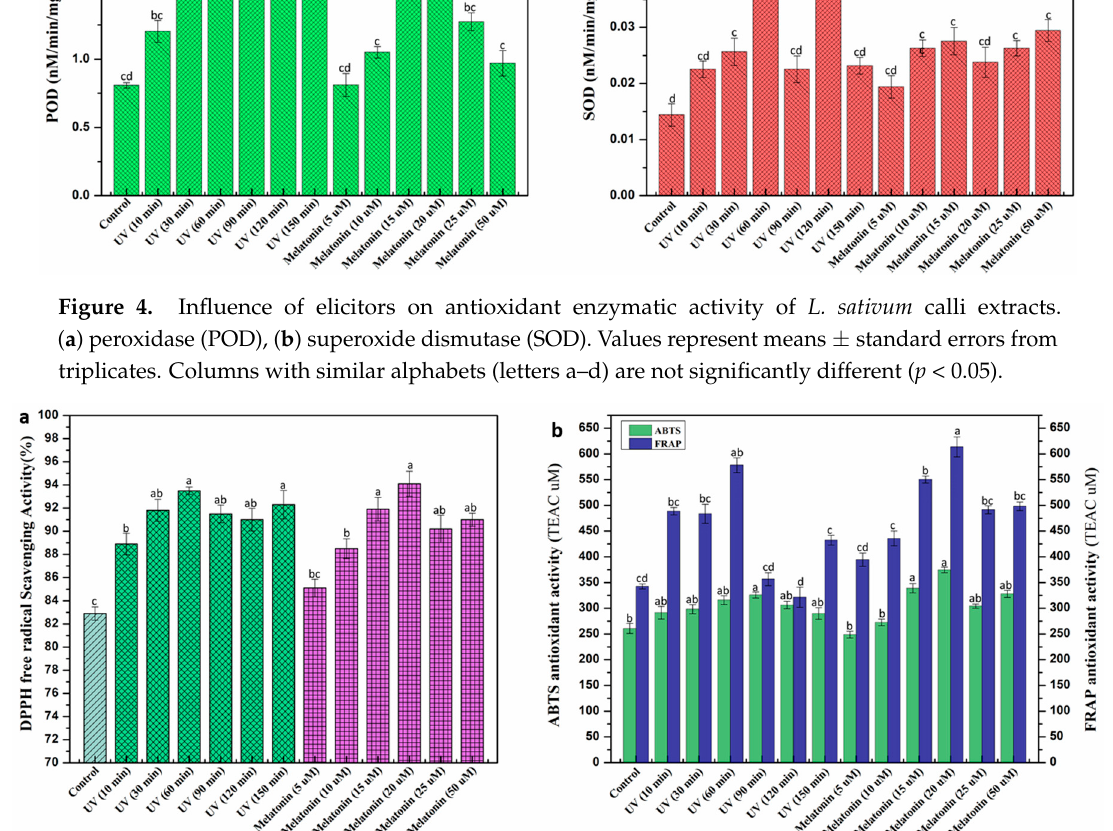
Figure 5. In vitro antioxidant potential of L. sativum callus culture ( a ) DPPH free radical scavenging activity (%), ( b ) ABTS and ferric reducing antioxidant power (FRAP) assay (TEAC: Trolox C equivalent antioxidant activity, expressed in µ M). Values represent means ± standard errors from triplicates. Columns with similar alphabets (letters a–d) are not significantly different ( p < 0.05).